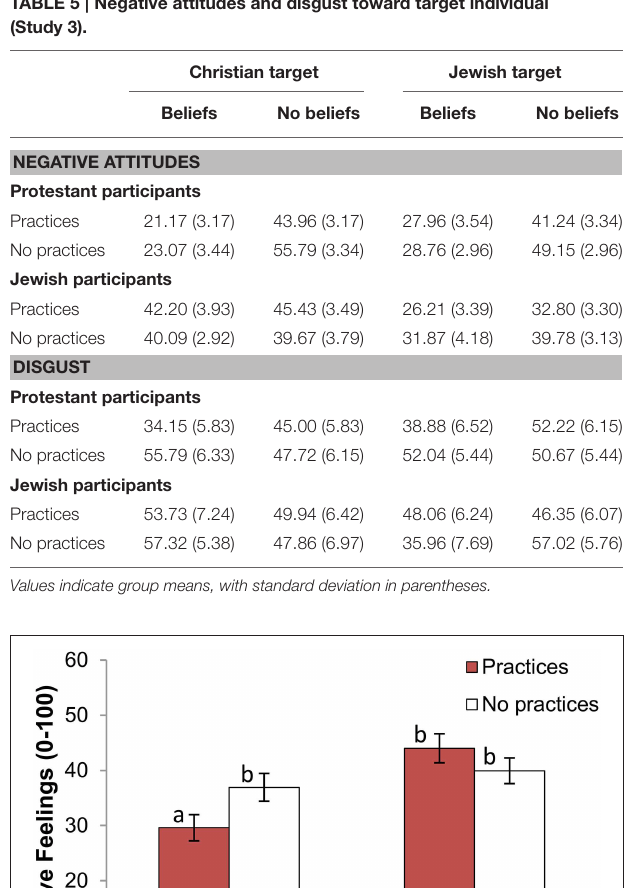
toward a Jew who practiced than one who did not, F (1 , 134) = 4 . 41, p = 0 . 04, η 2 = 0 . 032 (see Table 5 ); however, they did not rate practicing and non-practicing Christians any differently, F (1 , 132) = 1 . 38, p = 0 . 24, η 2 = 0 .